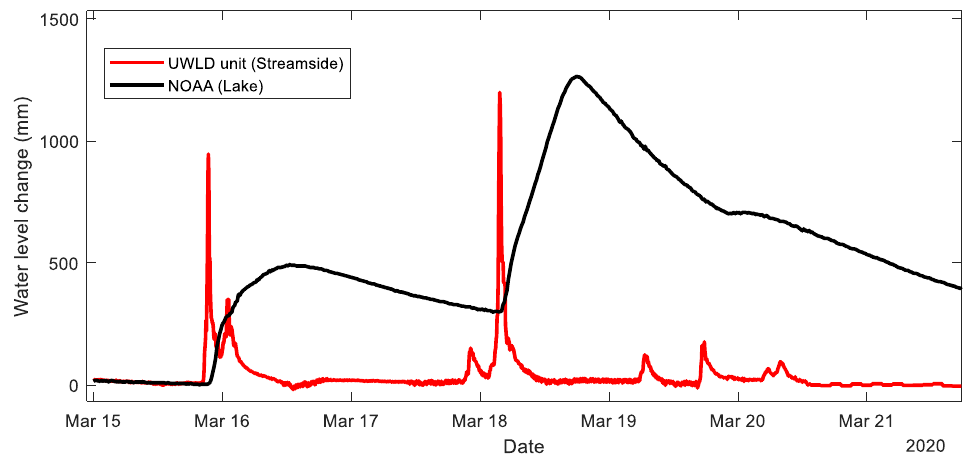
Figure 15. Water level changes measured by Node 1 streamside and Lake Arlington NOAA for 7 days (15–21 March